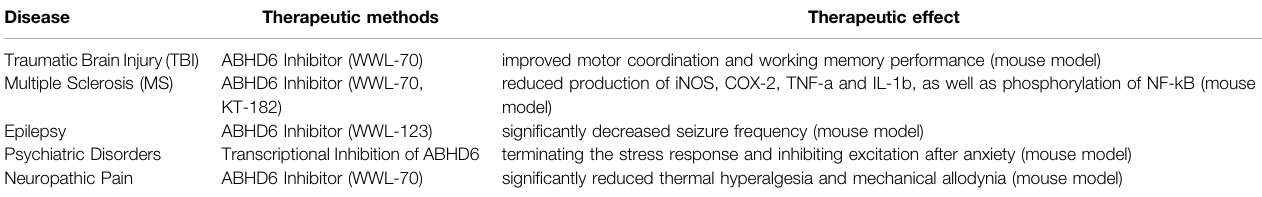
TABLE 1 | Overview of reported neurological disease treatments targeting ABHD6. Disease Therapeutic